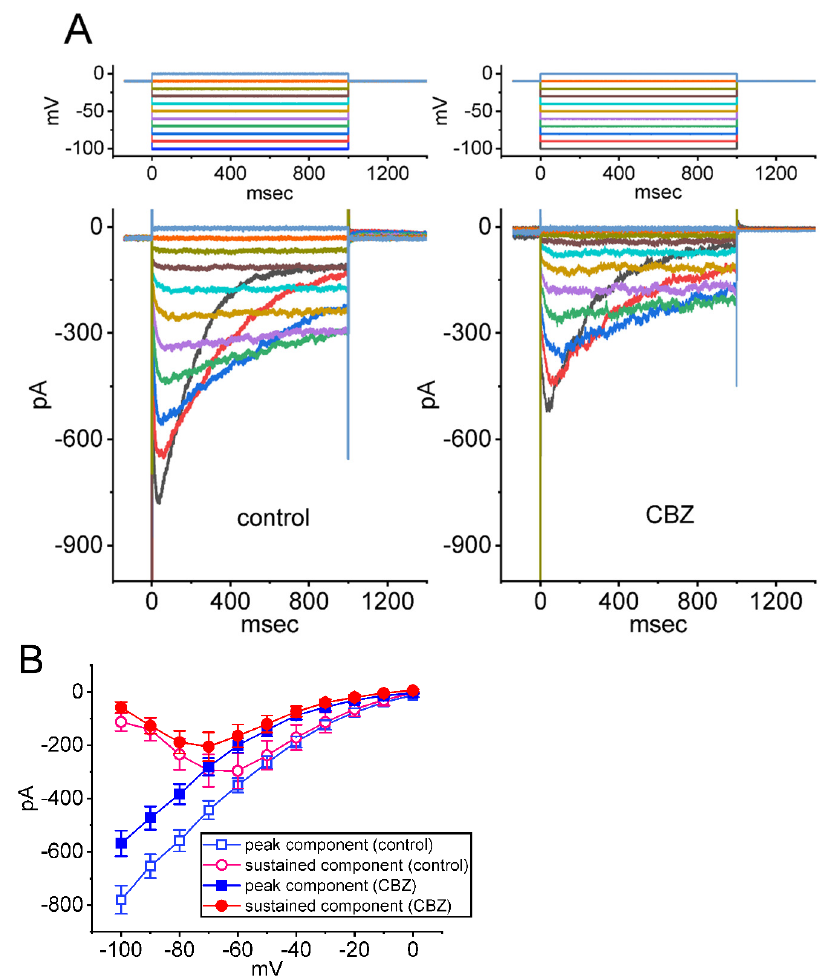
Figure 7. Inhibitory effect of CBZ on the steady-state I-V relationship of hyperpolarization-activated erg -mediated K + current ( I K(erg) ) identified in Neuro-2a cells. In these experiments, we put cells in a high-K + , Ca 2+ -free solution which contained 1 µ M TTX and 0.5 mM CdCl 2 , and we filled up the recording pipette with a K + -enriched solution. The tested cell was voltage-clamped at − 10 mV and a series of command potentials ranging between − 100 and 0 mV for 1 s was imposed on it. ( A ) Representative current traces were acquired in the control period (left side, absence of CBZ) and during exposure to 100 µ M CBZ (right side). The voltage clamp protocol is illustrated in the upper parts of current traces with or without the application of CBZ. ( B ) Average I–V relationships of the peak (blue squares) or sustained component (red circles) of I K(erg) acquired in the control period (open symbols) and during exposure to 100 µ M CBZ (filled symbols). The peak and sustained amplitudes of deactivating I K(erg) were obtained at the beginning and end-pulse of each step command applied. Each data point indicates the mean ± SEM (n = 8). The statistical analyses made with or without